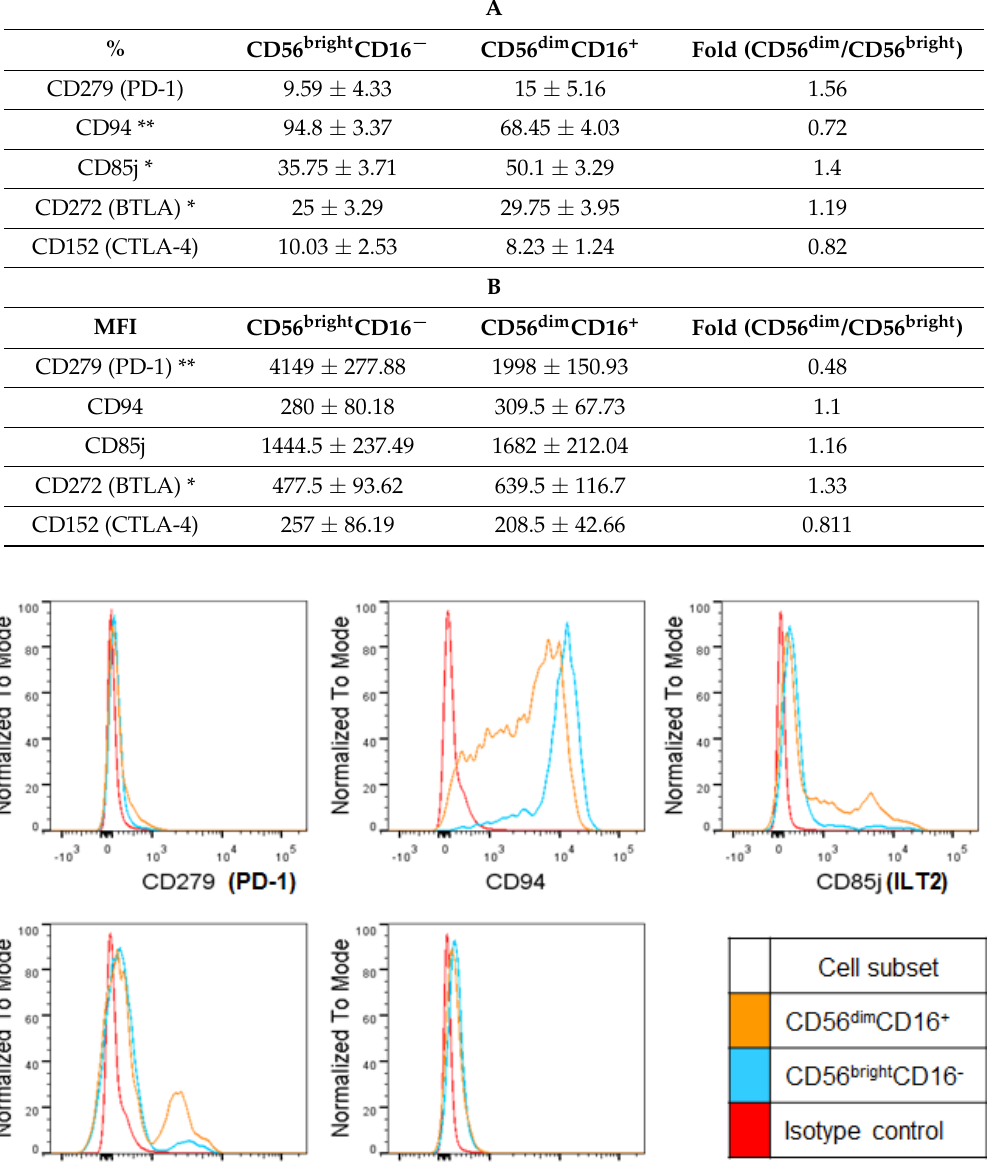
Table 2. Percentages and mean fluorescence indices (MFI) of immune checkpoint or inhibitory receptor-expressing CD56 bright or CD56 dim HI NK cells. Percentages (upper panel A ) and MFI (lower panel B ). N = 10. Statistical analysis was performed as above. * p < 0.05, ** p < 0.01.